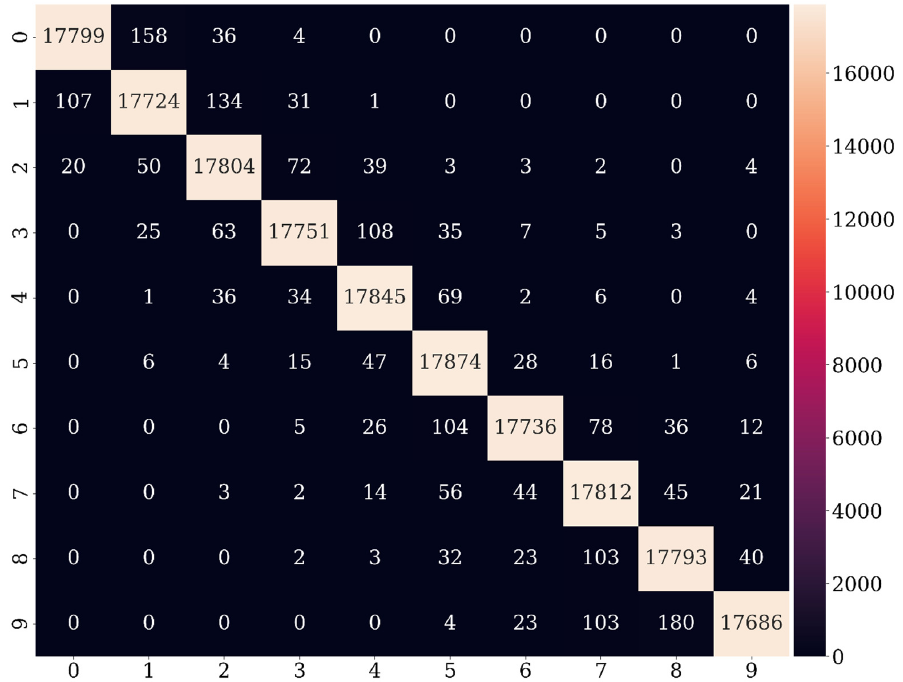
Figure 4. The confusion matrix corresponding to classification performed using a neural network trained on a dataset with 10-component output vectors. The data correspond to ten transmission eigenchannels of three devices with three different scattering strengths N s . This classification allows for identification of the eigenchannel independent of the disorder strength. The maximum value in any cell can be 18,000.